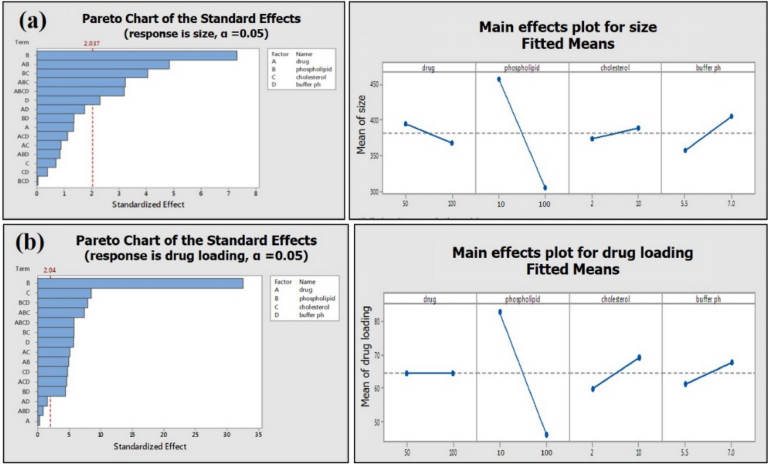
Figure 9. Pareto chart and main e ff ect plot of material attributes (MA) on ( a ) average phytosome size and ( b ) drug loading e ffi